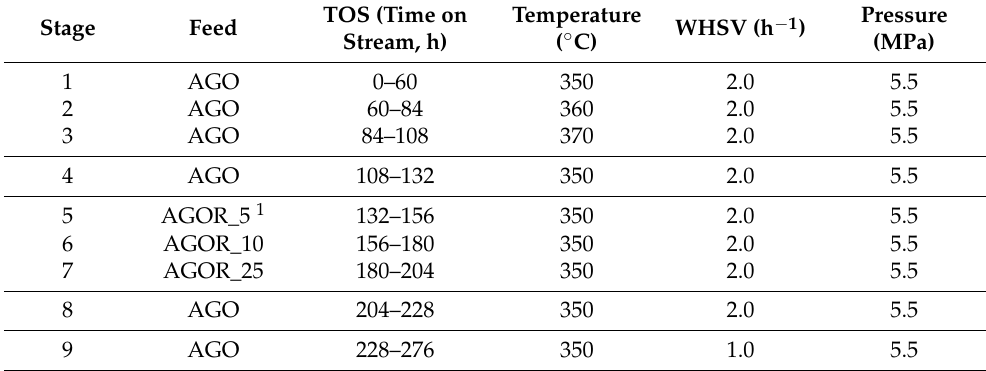
Table 1. Description of reaction conditions in chronological